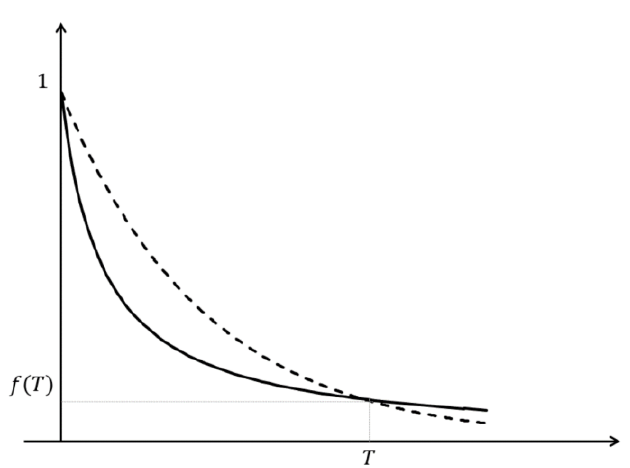
Figure 1. Representation of a hyperbolic discount function and the related empirical function.